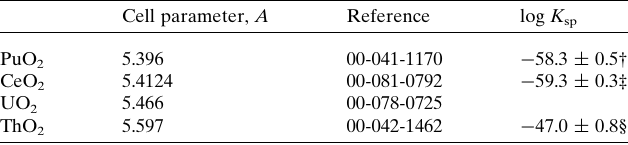
Table 3 Cell parameter and solubility product constant ( K sp ) for studied series